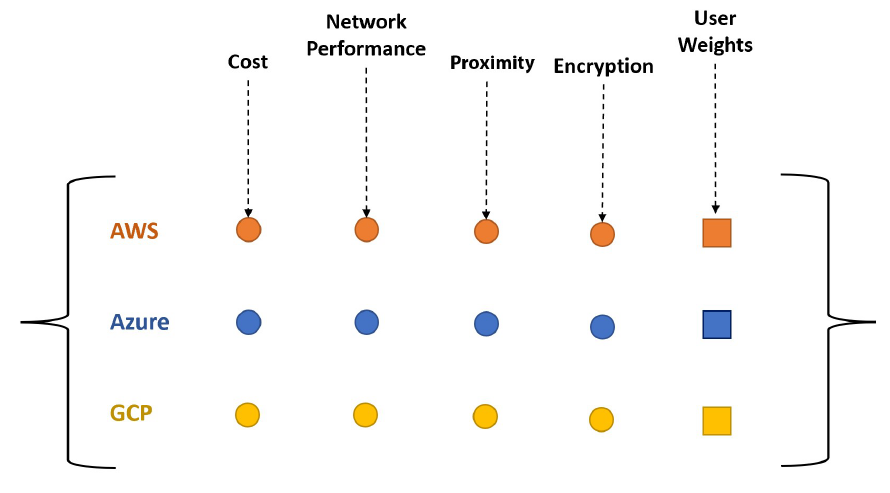
Figure 5. Evaluation matrix used for ranking cloud storage